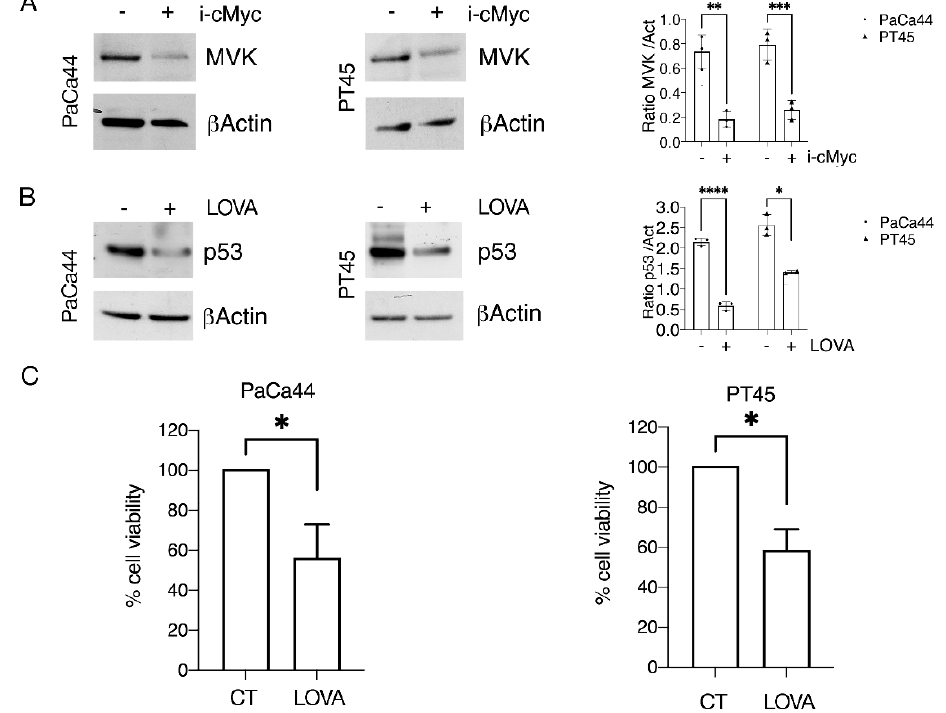
Figure 4. Role of the mevalonate pathway in sustaining mutp53 expression level and pancreatic cell survival. PaCa44 and PT45 cells were treated with cMyc inhibitor (i-cMyc) (50 µ M) ( A ) or with Lovastatin (LOVA) (30 µ M) ( B ) for 48 h to evaluate mevalonate kinase (MVK) or p53 expression by Western blot analyses. β Actin was used as loading control and one representative experiment is shown. The histograms represent the mean ± SD of densitometric analysis of the ratio of MVK/Act and p53/Act. p value: * <0.05; ** <0.01; *** <0.001; **** <0.0001; ( C ) cell survival of PaCa44 and PT45 cells treated with LOVA (30 µ M) for 48 h was evaluated by trypan blue exclusion assay. The histograms represent the mean plus SD of live cells as percent of untreated control cells, * p value: <0.05.